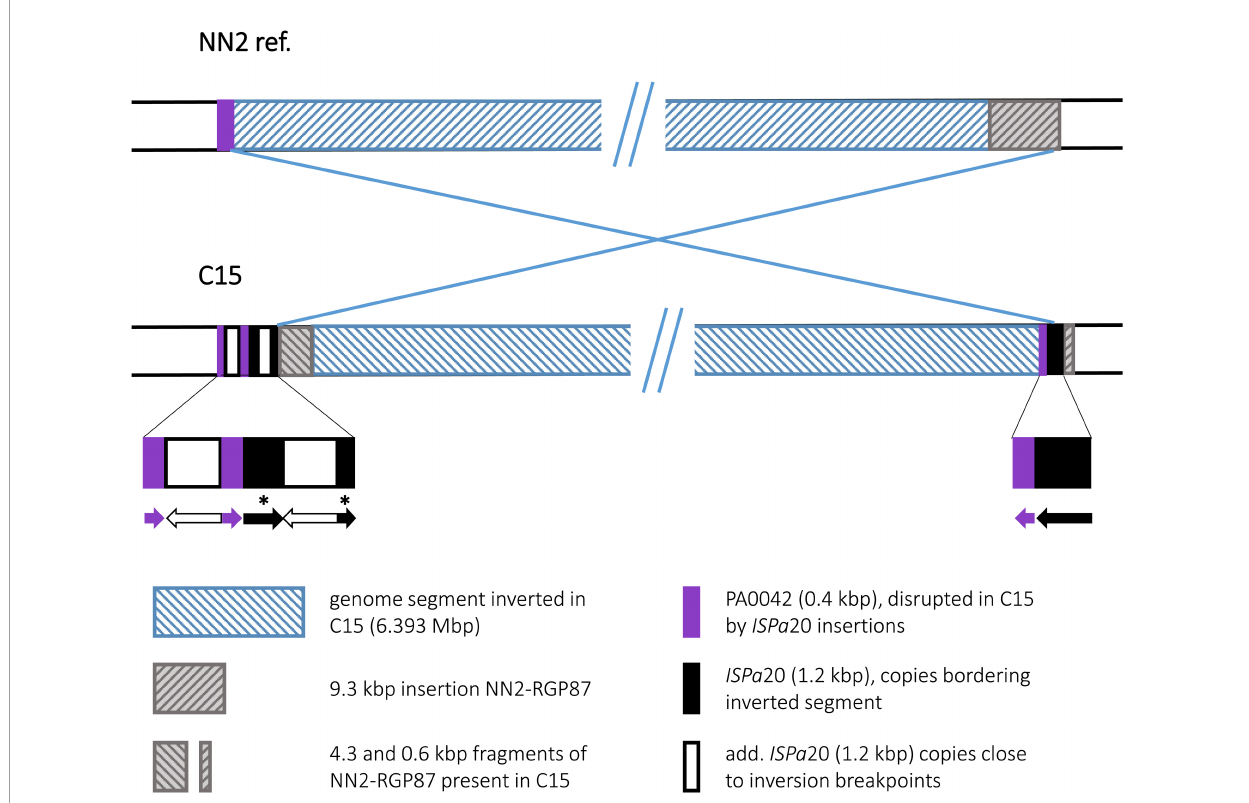
FIGURE6 Genomic inversion in strain C15. The inversion observed in C15 is characterized by a complex DNA arrangement at the left breakpoint. Several copies of an ISPa20 element were detected. Two ISPa20 copies had presumably provided the inversion recombination sequences, while others inserted later at the left breakpoint region. In order to show the DNA arrangement in more detail, a third panel was added to the figure displaying the composition at the breakpoints. Arrows indicating the 5 (cid:48) to 3 (cid:48) direction in these sequences symbolize the DNA orientation of the different ISPa20 copies and ORF PA0042 fragments. Fragments of an ISPa20 copy disrupted by the insertion of an additional copy are marked by